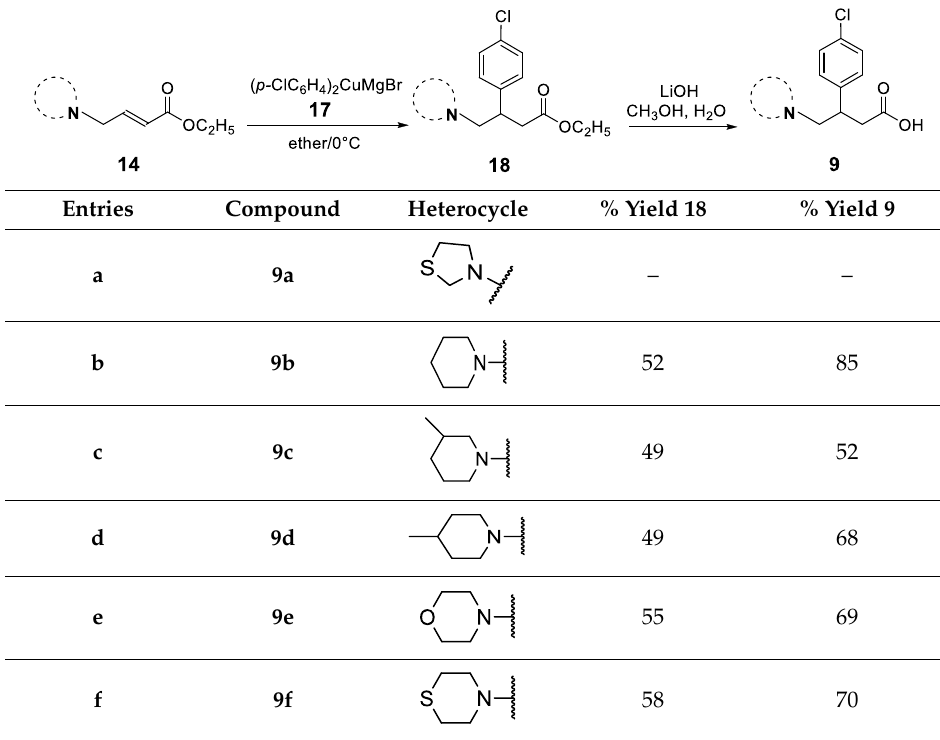
Table 4. Synthesis of the β -substituted analogues 9 .